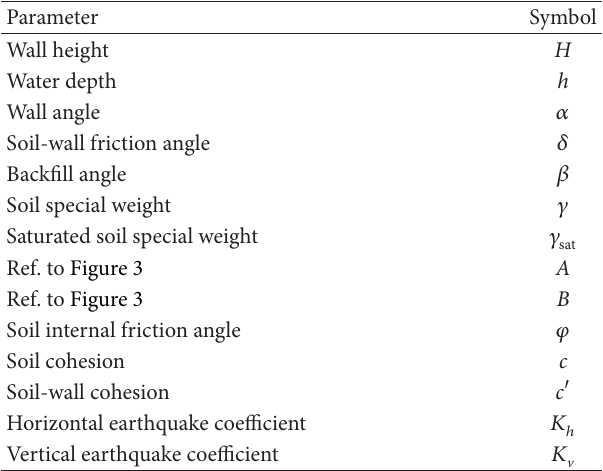
Table 1: Parameters of the proposed method.